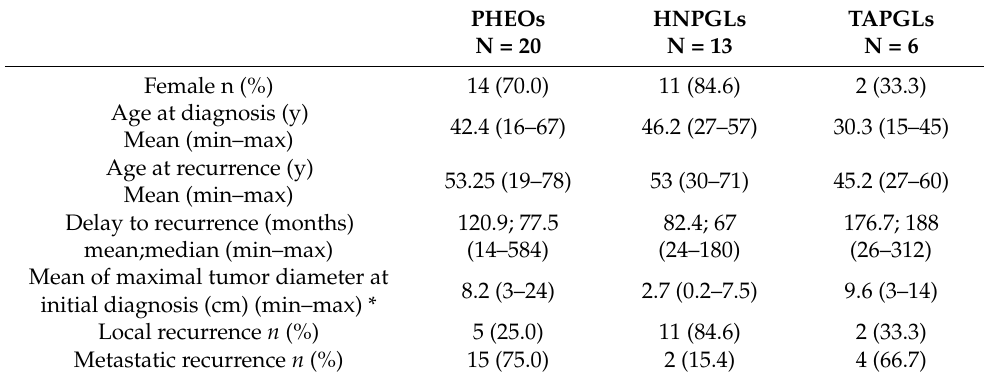
Table 2. Characteristics of patients with recurrent